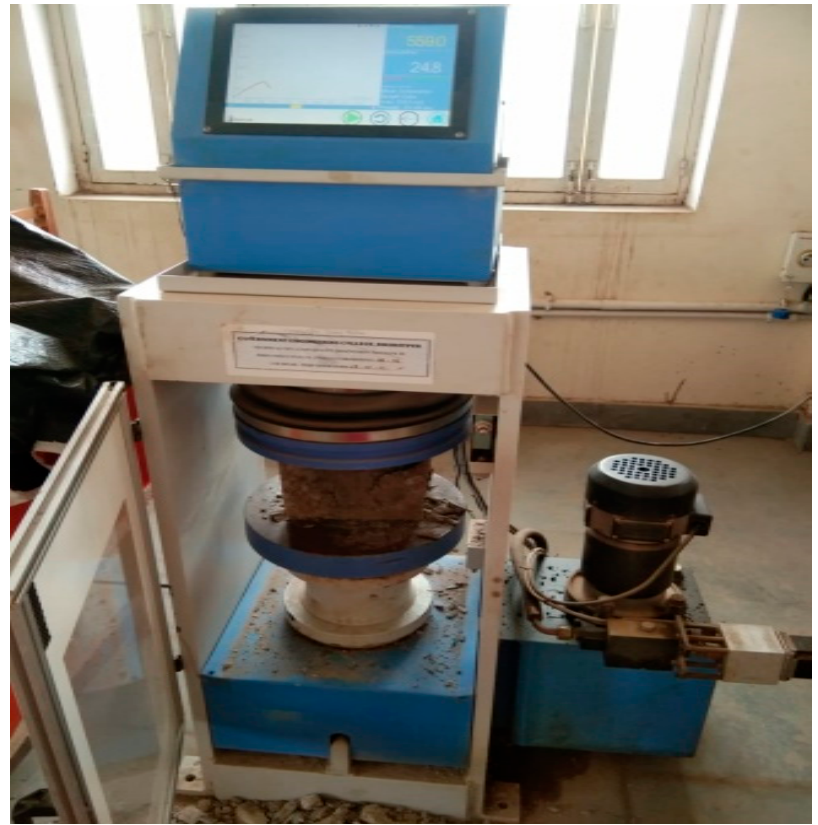
Figure 1. Experimental setup of fly-ash/calcined-clay-based geopolymer concrete. Data Collection Data Collection